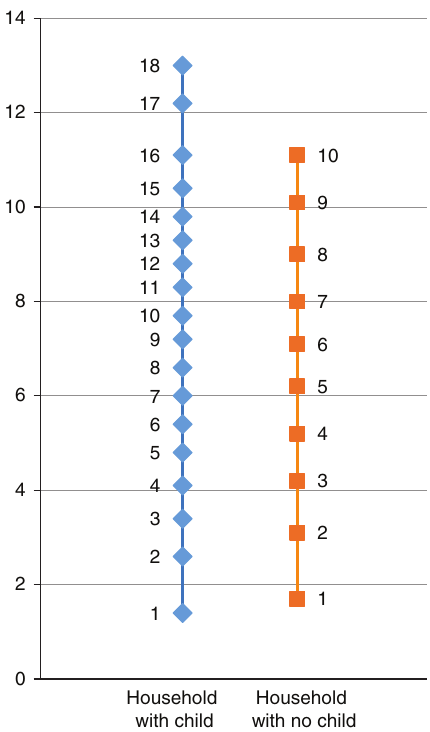
Figure 1 Severity of food insecurity (latent trait measure), by raw score for households with and Severity of food insecurity (latent trait measure), without children by raw score for households with and without